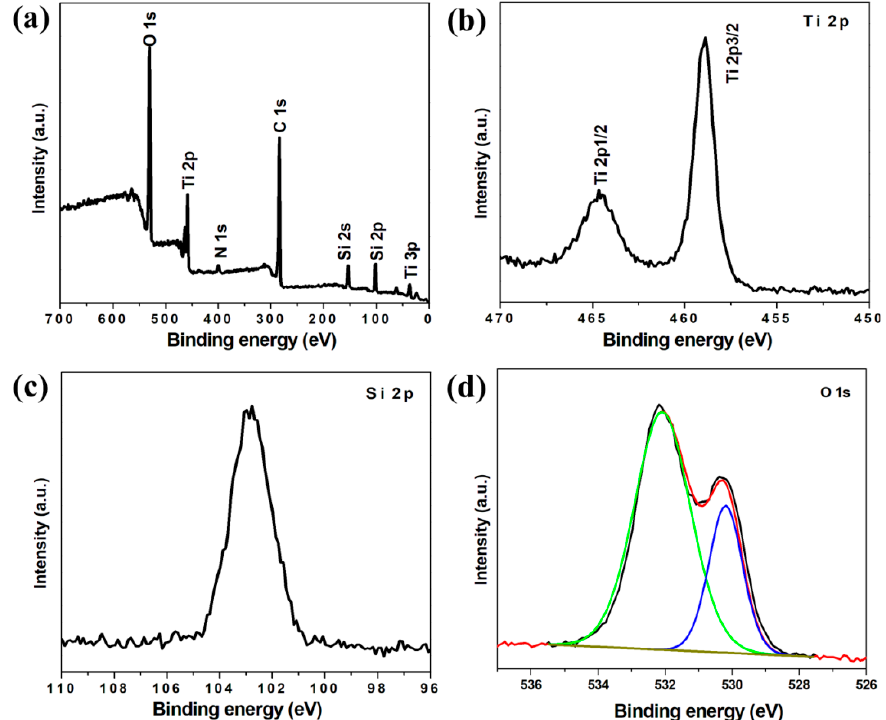
Figure 3. ( a ) Survey XPS spectrum of TSC nanofibers and the corresponding high-resolution ( b ) Ti 2p, ( c ) Si 2p and ( d ) O 1s XPS spectra.